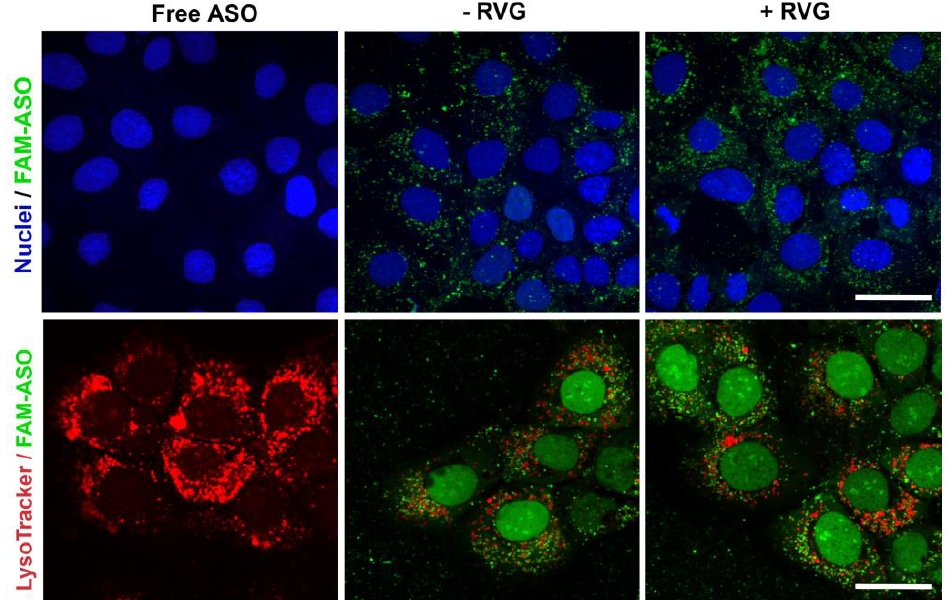
Figure 6. Cellular uptake and late endosome/lysosome escape of RVG-targeted cyclodextrins (CD)s:ASO nanocomplexes. Representative confocal fluorescence images of ST14A (1.5 × 10 6 ) cells treated with ASO alone or complexed with CDs (100 nM final concentration) for 6 h. Intracellular fluorescence of FAM-labelled ASO (green), nuclei (blue), and LysoTracker Red DND-99 (red). The yellow color indicates co-localization. Scale bar: 25 µm.